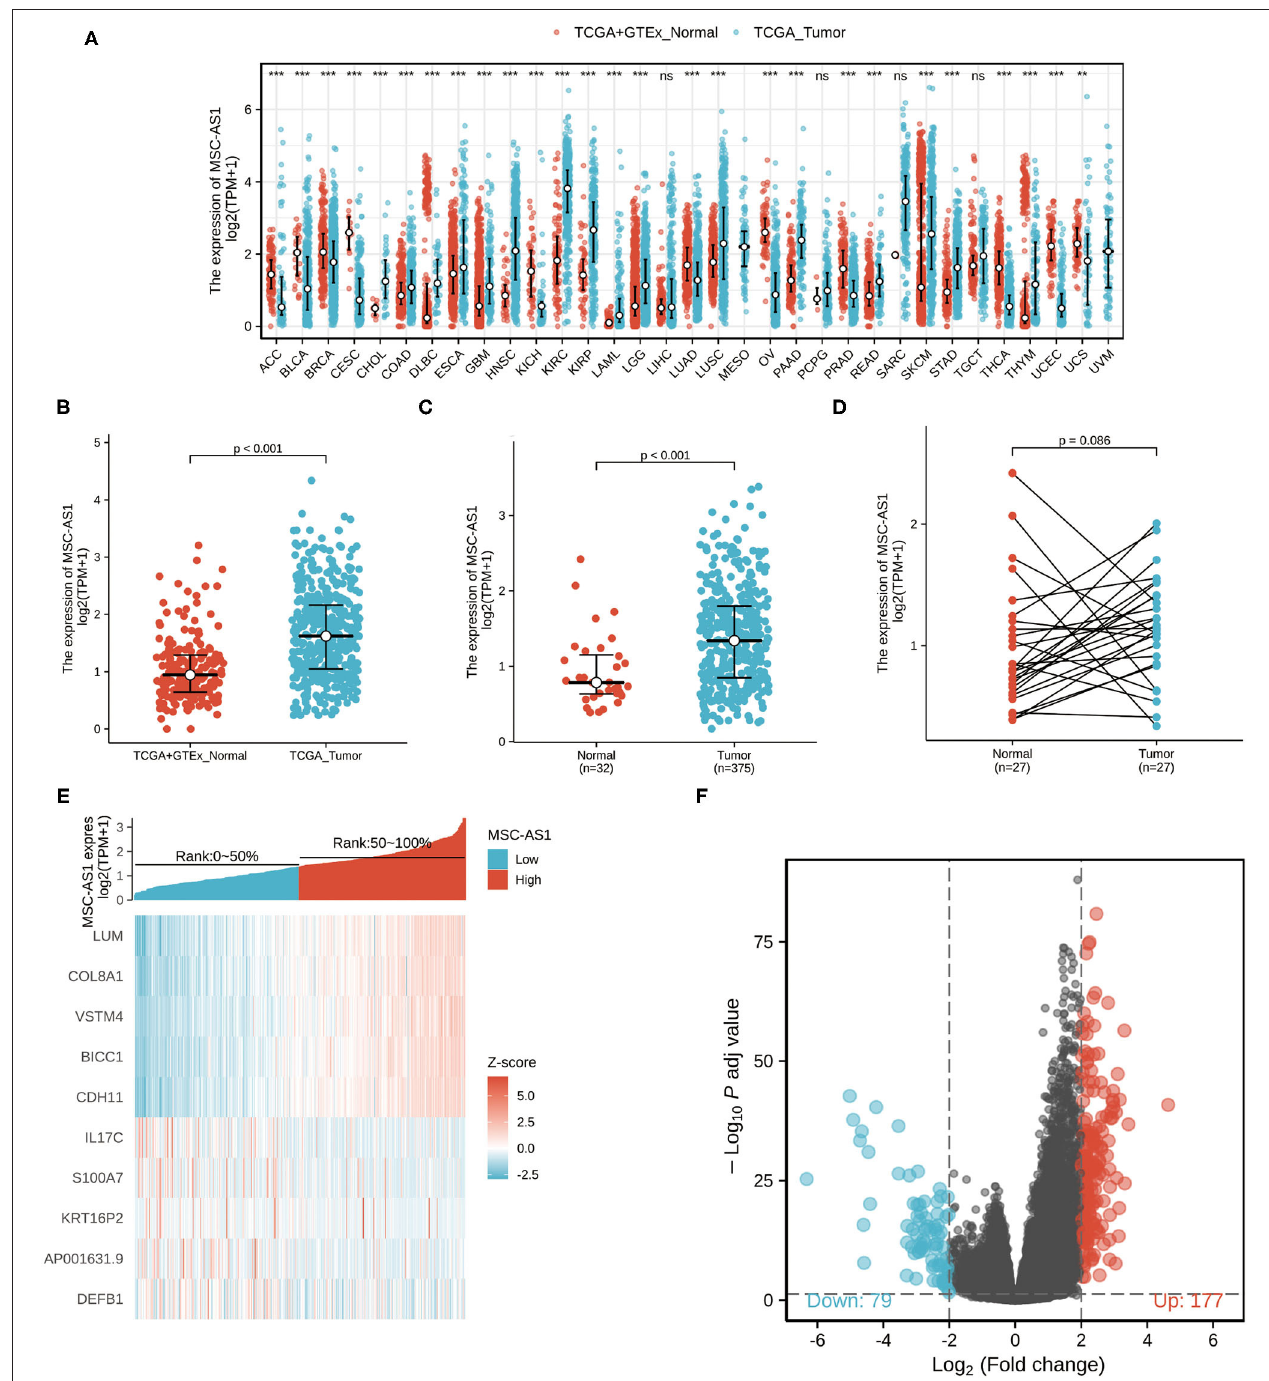
FIGURE 1 | The expression of long non-coding RNA MSC-AS1 in (A) in Genotype-Tissue Expression (GTEx) and normal The Cancer Genome Atlas (TCGA) samples with corresponding TCGA tumor samples; (B) in GTEx and normal TCGA samples with TCGA gastric cancer gastric cancer (STAD) samples; (C) in 375 gastric cancer tissues and 32 normal tissues in TCGA database; and (D) in 27 pairs of gastric cancer tissues and non-cancerous adjacent tissues in TCGA database; (E) Volcano plot of differentially expressed long non-coding RNAs (lncRNAs). Normalized expression levels are shown in descending order from green to red. There 177 differential molecules had log2FC > 2 and adjusted p < 0.05, and 79 differential molecules had log2FC < − 2 and adjusted p < 0.05. (F) Heat map of the 10 differentially expressed long non-coding RNAs (lncRNAs). The X-axis represents the expression of lncRNA MSC-AS1, while the Y-axis denotes different the differentially expressed lncRNAs. Green and red tones represent downregulated and upregulated lncRNAs, respectively.